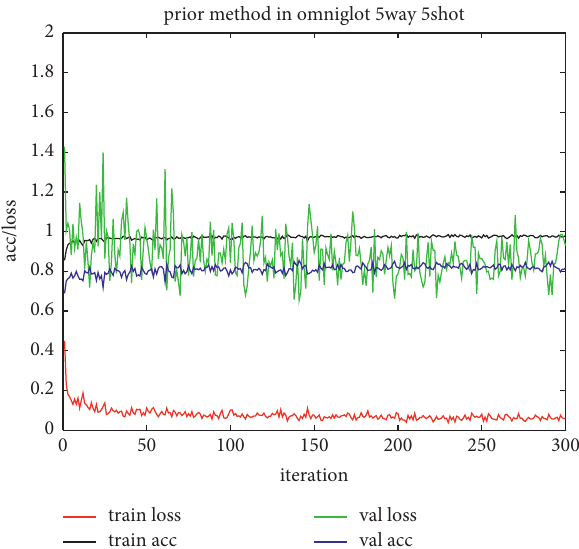
Figure 6: Performance of CACTUs-MAML on